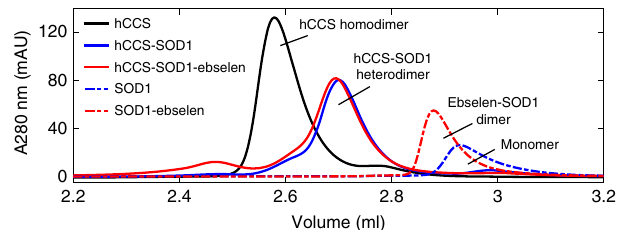
Fig. 3 Ebselen does not prevent heterodimer formation with hCCS. Size exclusion chromatograms showing how ebselen binding to C57/146A SOD1 promotes dimerization (blue dashed line to red dashed line) but does not inhibit heterodimeric complex formation with wild-type hCCS, which exists in homodimeric state prior to complexation